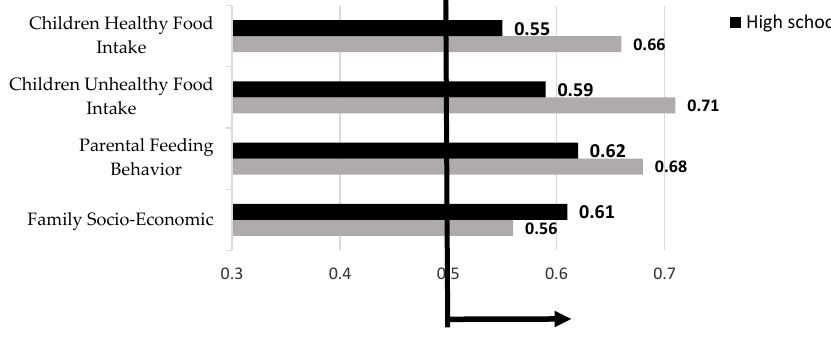
Figure 7. AVE analysis outputs.